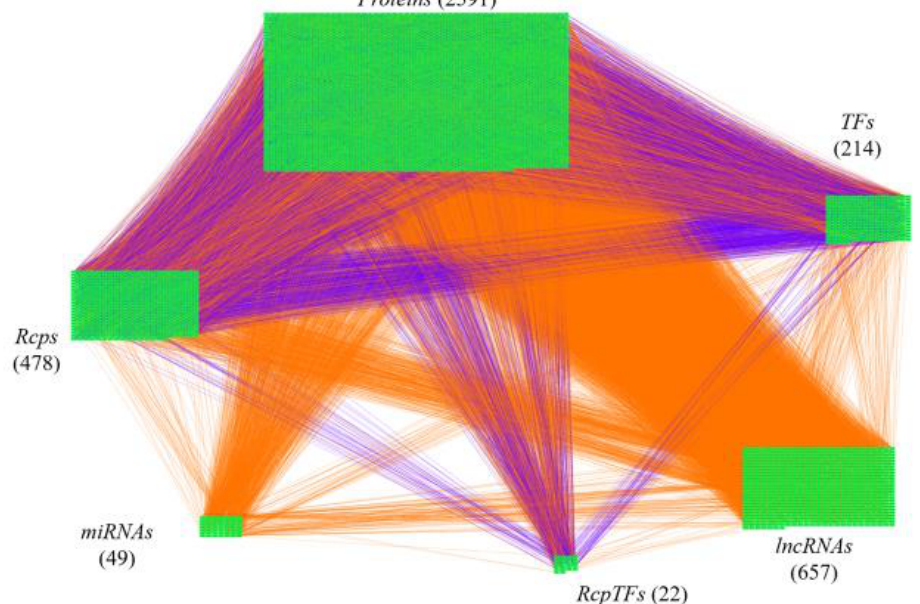
Figure 3. The core host-pathogen interspecies genome-wide genetic and epigenetic network (core HPI-GWGEN) of non-viral ARDS. Purple lines indicate the protein – protein interactions and orange lines denote the gene regulations. The nodes numbers of proteins, Rcps, TFs, RcpTFs, miRNA, LncRNA are 2591, 487, 214, 22, 49, and 657, respectively.